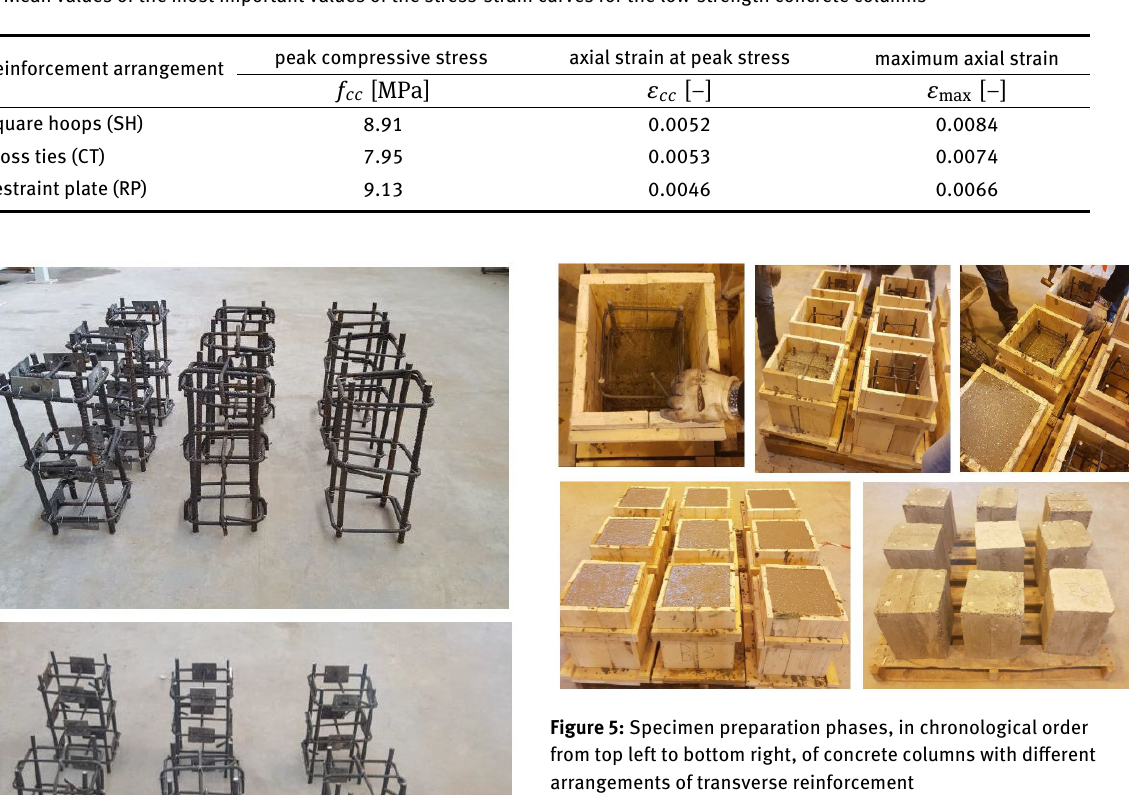
Table 1: Mean values of the most important values of the stress-strain curves for the low-strength concrete columns